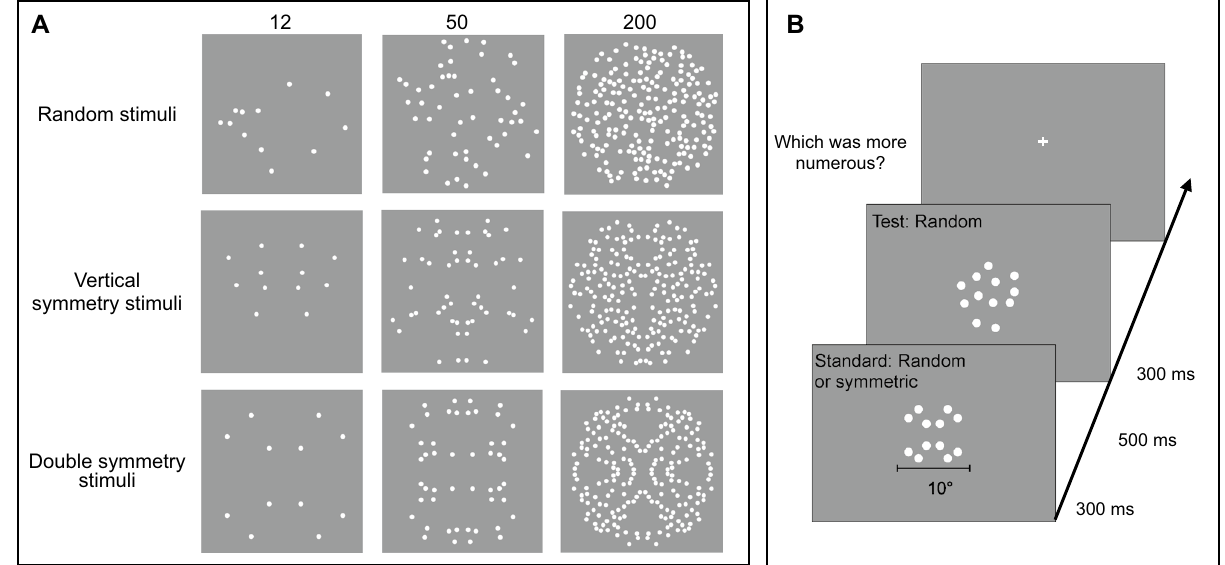
Figure 1. Illustration of the stimuli and procedure for Experiment 1 and 2. ( A ) Examples of standard stimuli for N12, N50 and N200. ( B ) On every trial, participants were required to indicate which of two stimuli was more numerous. The standard and the test were randomly presented as first or second